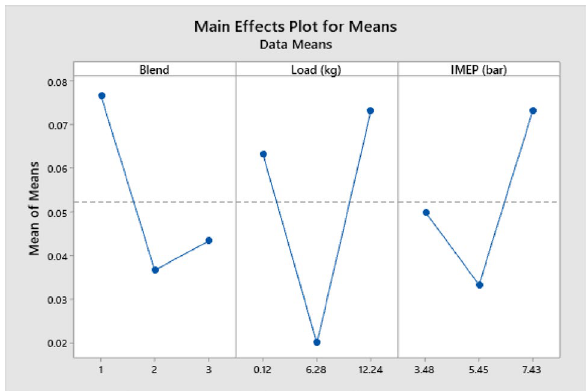
Fig. 6 Investigation by Taguchi: CO versus blend, load (kg), IMEP (bar)